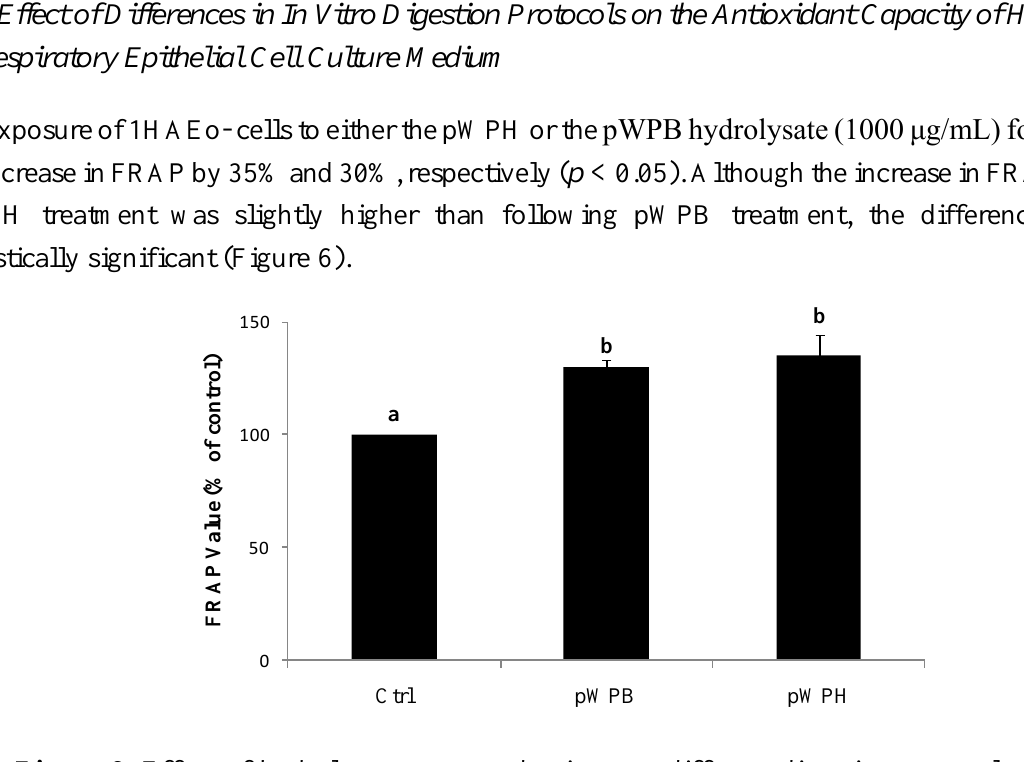
Figure 6. Effect of hydrolysates prepared using two different digestion protocols (pWPH (current protocol) versus pWPB (protocol of Vilela et al . (2006) [26]) on FRAP of cell-free supernatants. 1HAEo- cells were incubated with either pWPH or pWPB (1000 μg/mL)